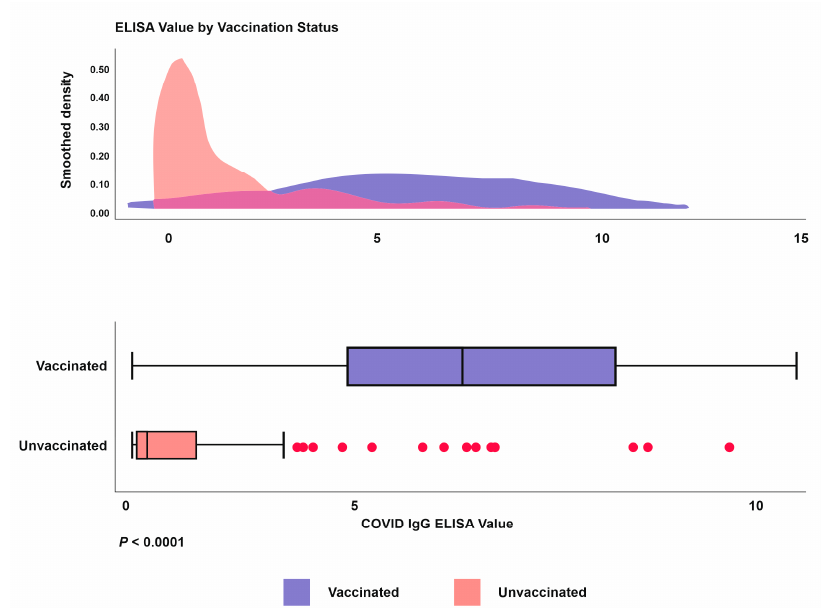
Figure 4. Density distribution and comparison of COVID-19 IgG ELISA value among vaccinated and non-vaccinated individuals. The box plots show the distribution of ELISA between the vaccinated and non-vaccinated groups ( P < 0.0001 shows the significant difference using the Mann–Whitney U test).